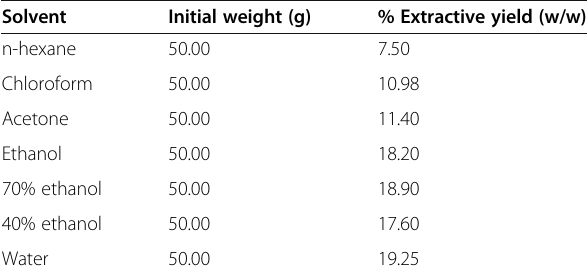
Table 1 The initial weight of MZFP sample and percentage extractive yield in different organic